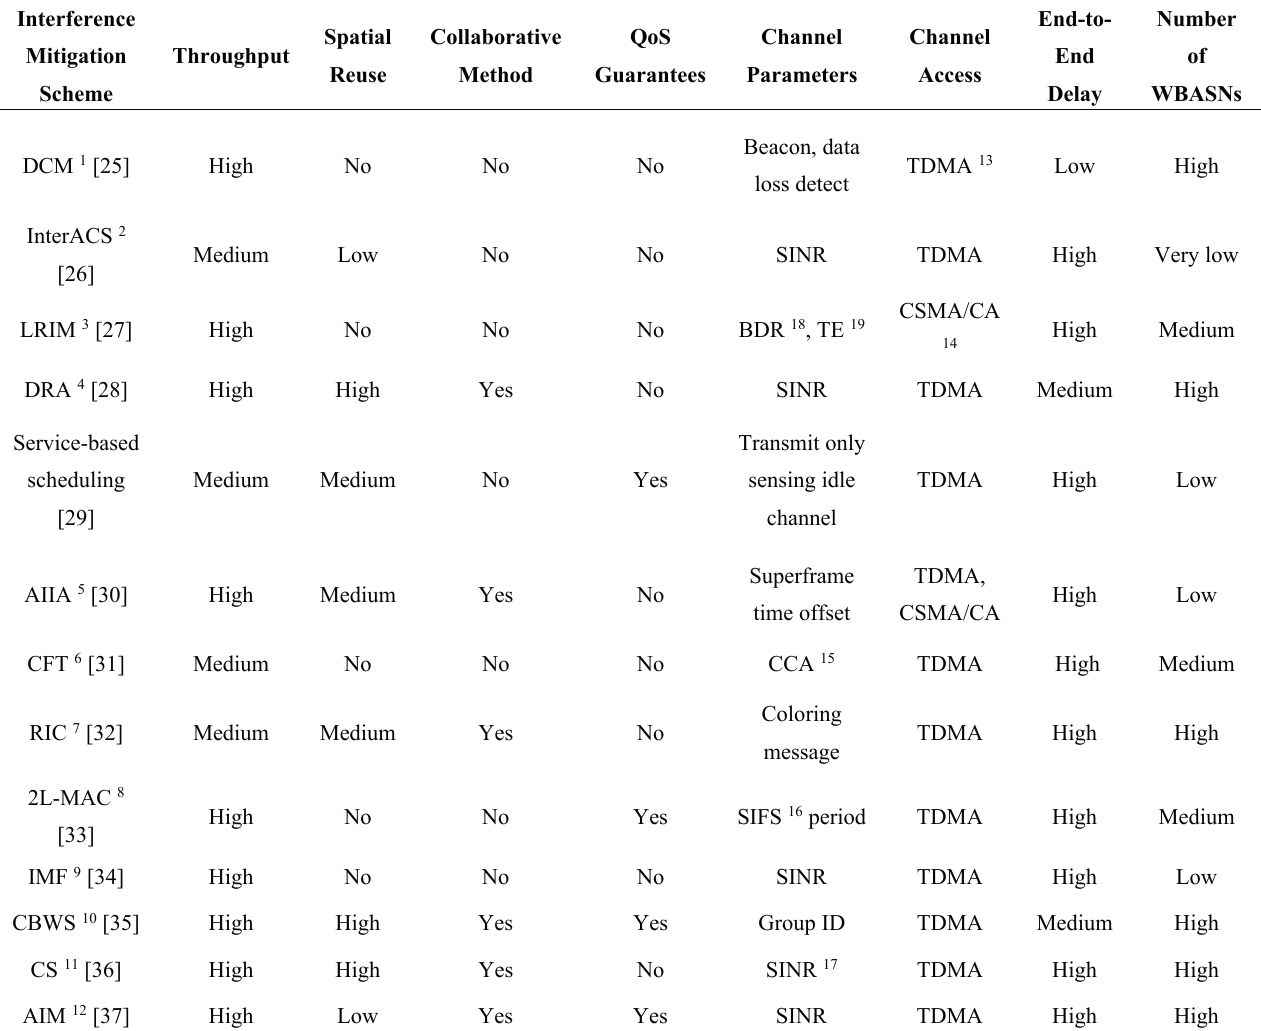
Table 2. Comparison of the interference mitigation schemes in the MAC